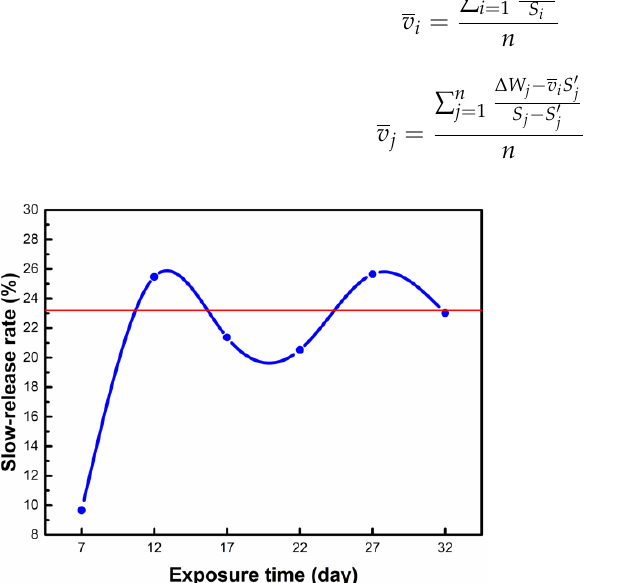
Figure 7. The sustained release rate of PSO/PDMS-PS relative to PSO/PDMS varies with the expo- sure time of PSO. exposure time of